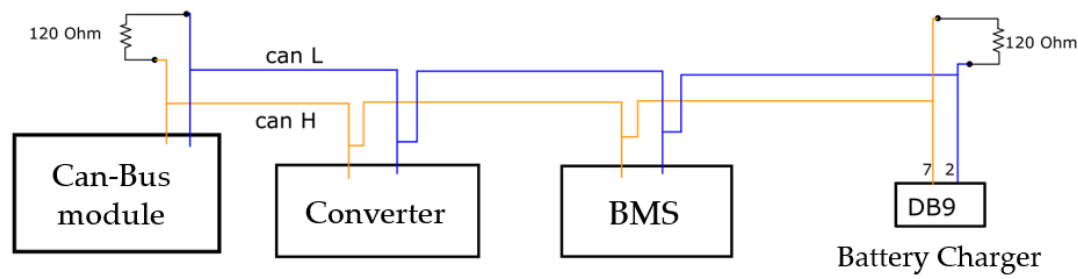
Figure 3. Can-Bus connection among the different devices of the electric system.